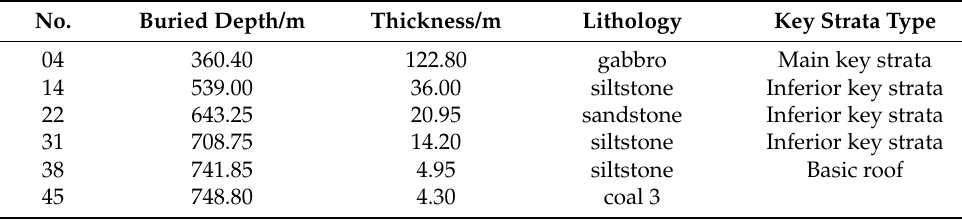
Table 1. Rock column diagram and the key strata types.